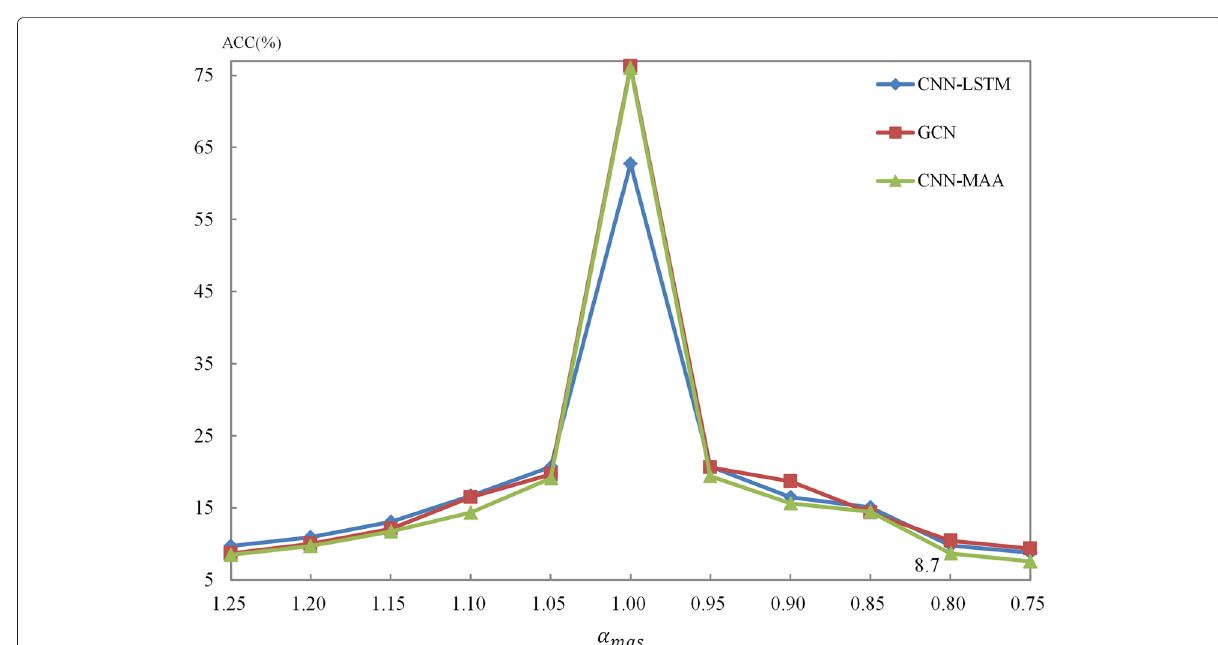
Fig. 7 Description of the three models under the McAdams transform attack